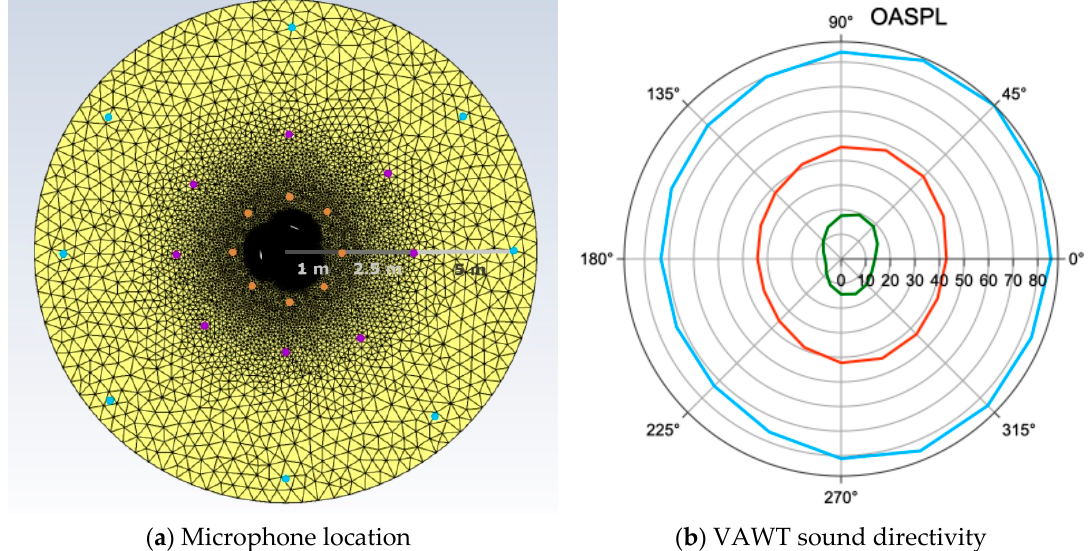
Figure 6. ( a ) Microphone location and ( b ) Sound directivity for an isolated VAWT. Curves quantify the Overall Sound Pressure Level (OASPL) at microphones located at 1 (blue), 2.5 (red) and 5 (green) meter radius from the turbine centre; 180° denotes the turbine front and 0° the rear.